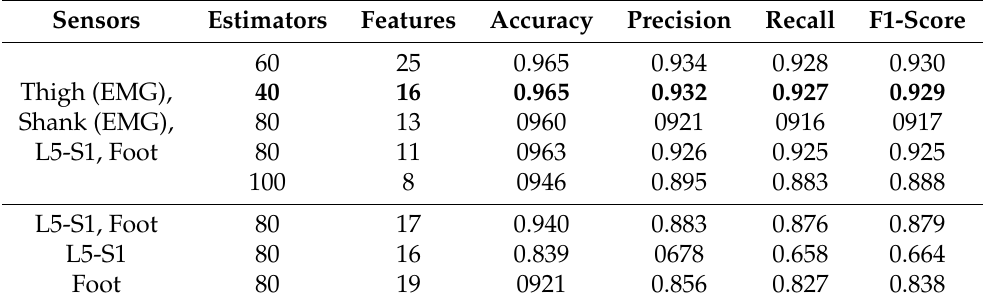
Table 7. Mean performance of the random forest model for fatigue detection in walking task using feature reduction and different sensors combinations. The best performance model is in bold .